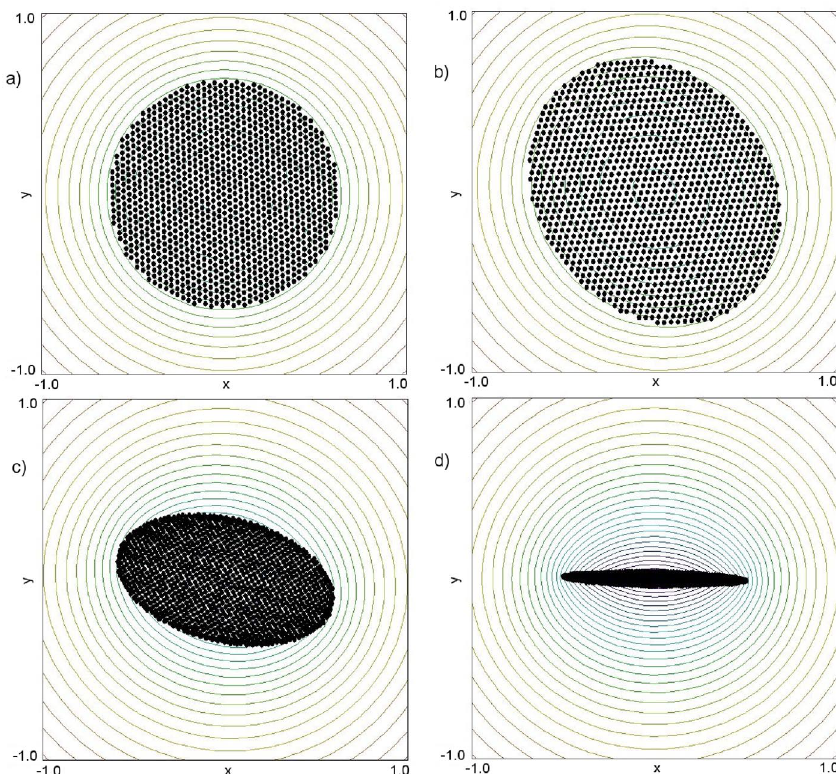
FIG. 7. (Color) Simulation particle distributions projected in planes normal to z and contours of the beam-generated electrostatic potential. (a) Gun output at the entrance to the transformation system, z (cid:1) (cid:6) 7 : 0 cm . (b) Lens midplane, z (cid:1) 0 : 0 cm . (c) Lens exit, z (cid:1) 3 : 0 cm . (d) Vertical focal point, z (cid:1) 7 : 6 cm